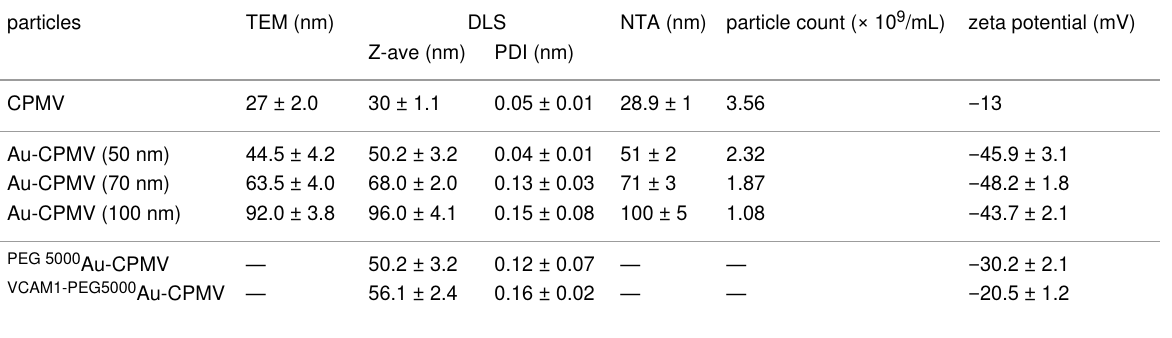
Table 1: Size, particle count and zeta potential of bare (unfunctionalized) particles, functionalized NPs and CPMV. The concentration of the Au-CPMV particles was 0.5 mg/mL gold for all three particle sizes. Particle count (number of particles per mL) as measured by NTA, n = 6 measurements.